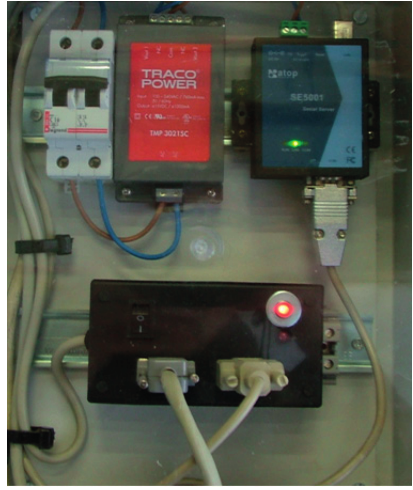
Figure 8. RS-485/Ethernet converter.